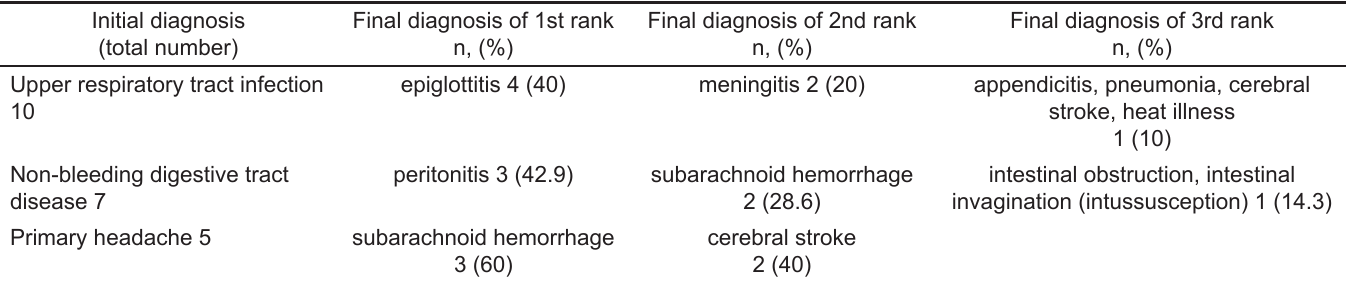
Table 4. Top three initial diagnoses of cases of diagnostic errors in non-trauma cases and their final